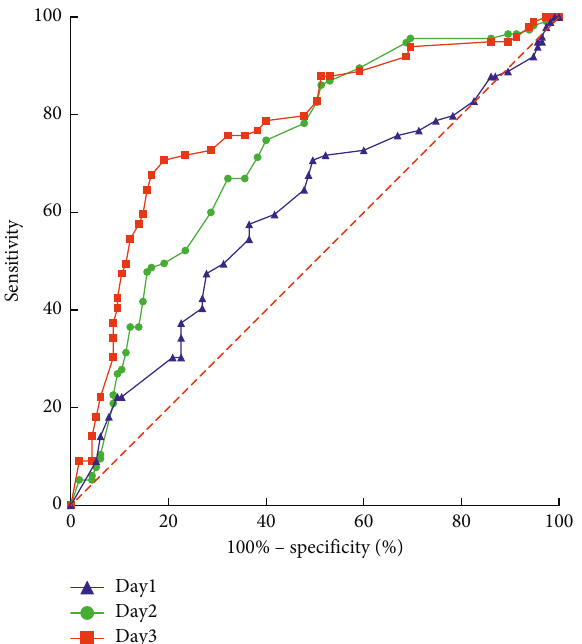
Figure 4: ROC curve of RALE score from day 1 to day 3. The area under the curve of day 3 was 0.773 (95% CI: 0.709–0.838), higher than day 1 and day 2.